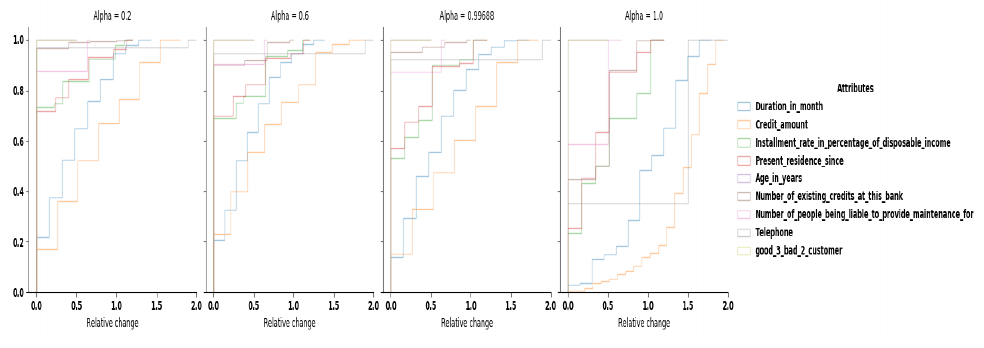
Figure A2. Relative change. Table A6. Evaluation of GANSan ’s protection on test. Values for reference points A, B and